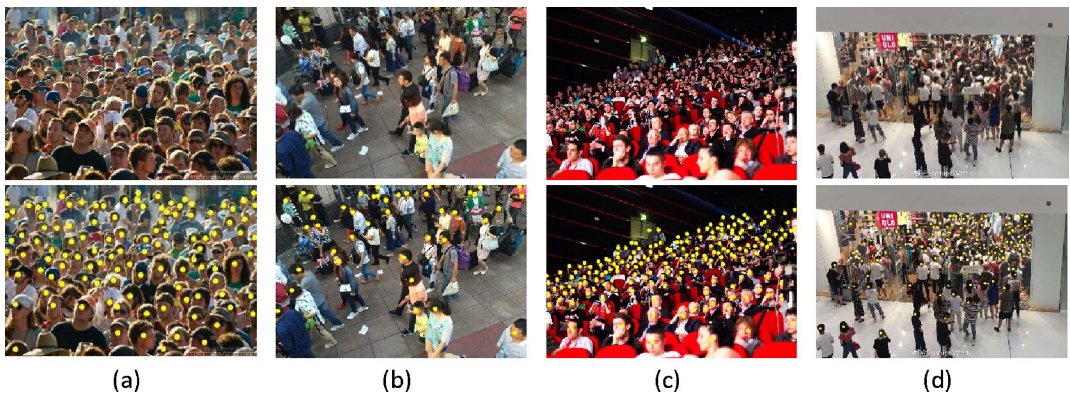
Figure 4. Visualization of crowd localization.